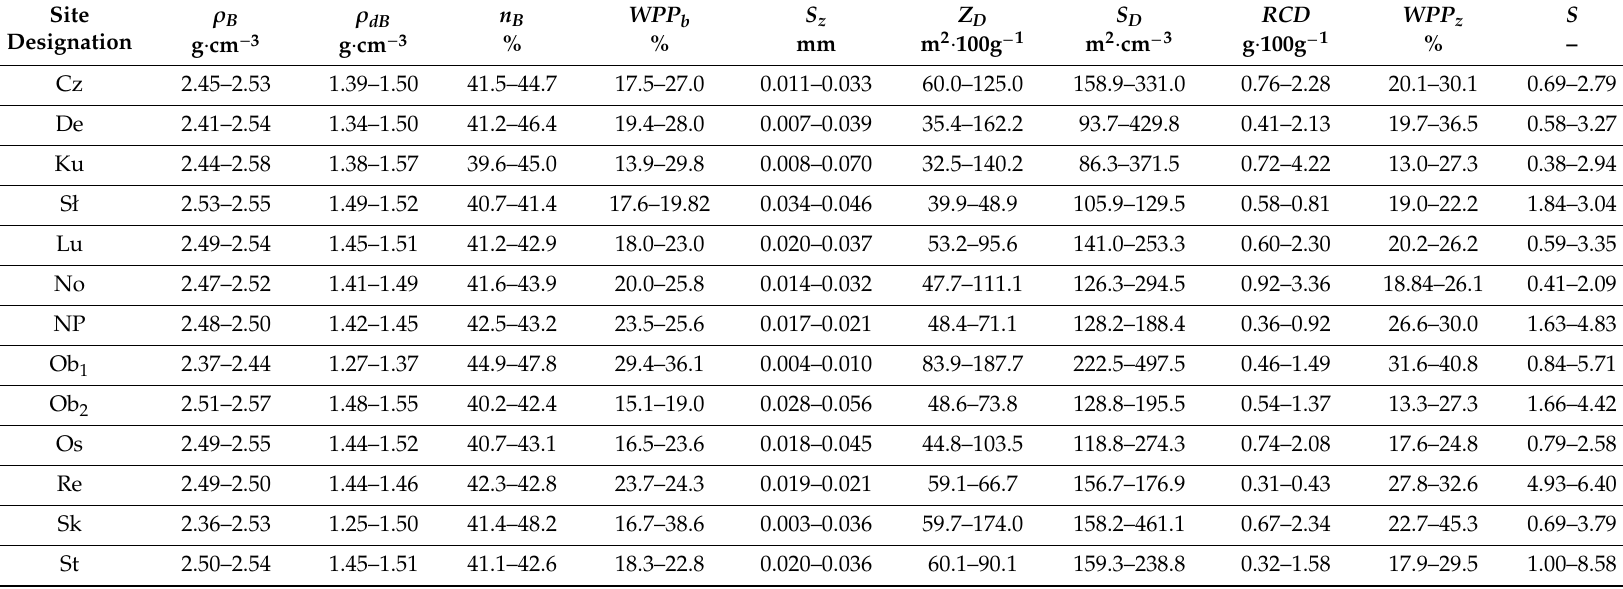
Table A2. Ranges of grouping parameters (the properties calculated on the basis of the results of the granulometric composition and the humus content) for individual sites in layer of 25–60